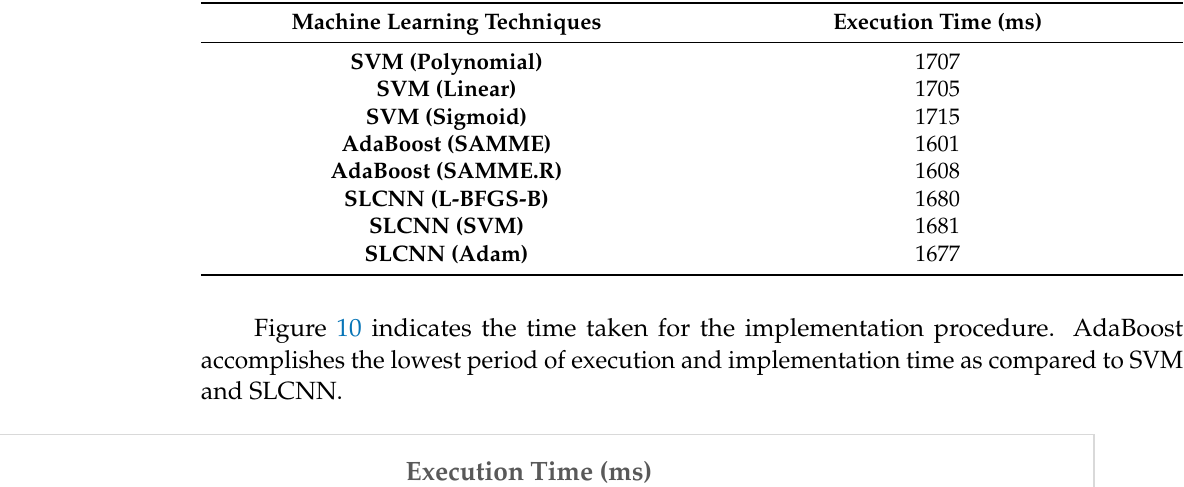
Table 7 indicates the implementation time and the prerequisite of classification tech- niques for text-based sentimental classification from the Guardian dataset. Table 7. Execution time of the Guardian dataset analysis for text-based sentimental classification.